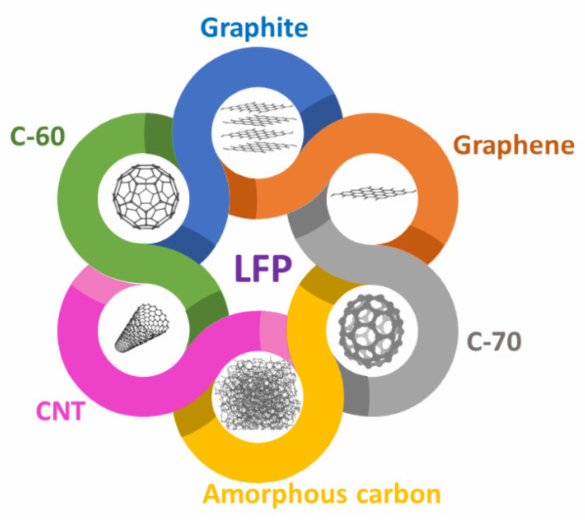
Figure 1. Schematic of possible carbon allotropes for